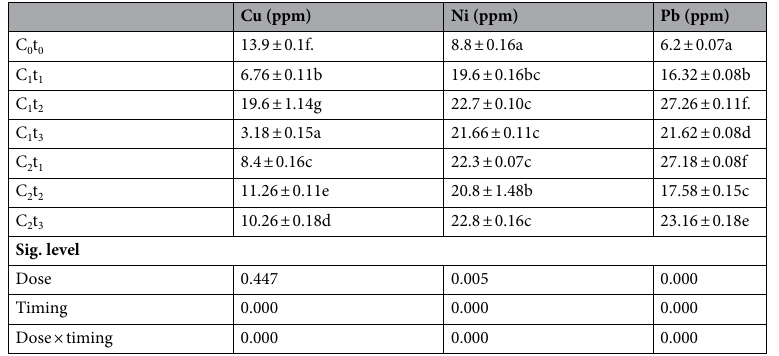
Table 8. Heavy metal composition of P. ostreatus mushrooms cultivated on supplemented substrates.